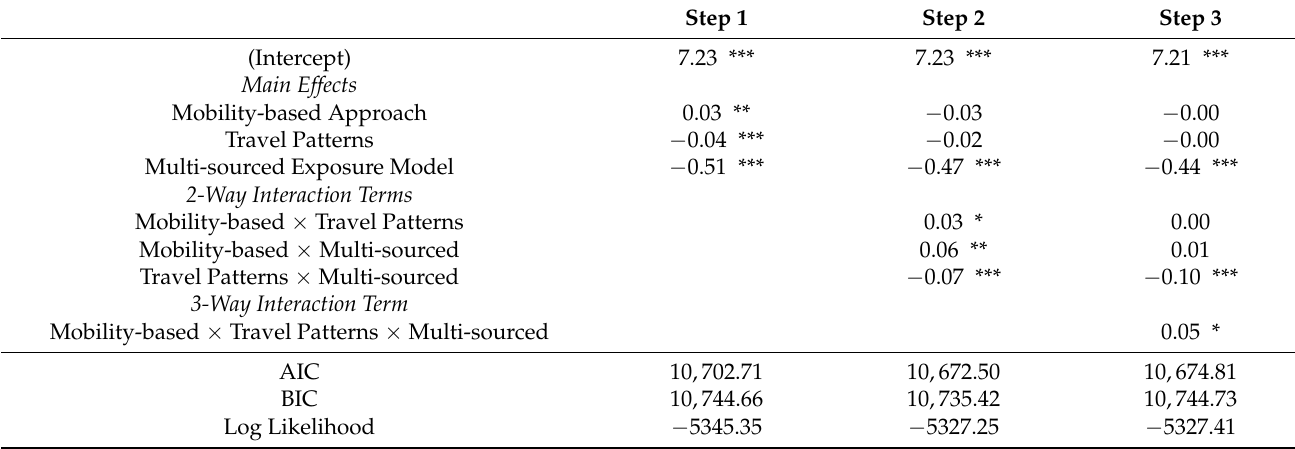
Table 4. Statistical